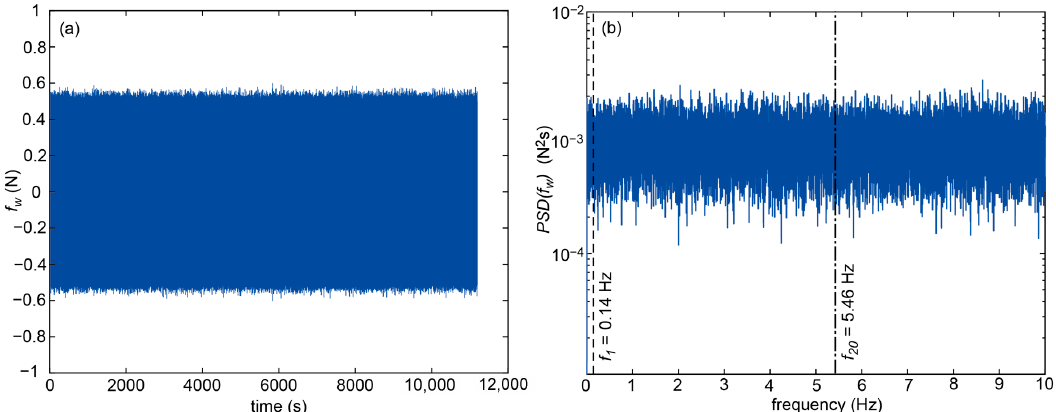
Figure 2. Excitation force of broadband excitation modeled as a band-pass-filtered white noise signal: ( a ) excitation force versus time; ( b ) power spectrum density estimate (PSD) of excitation force.